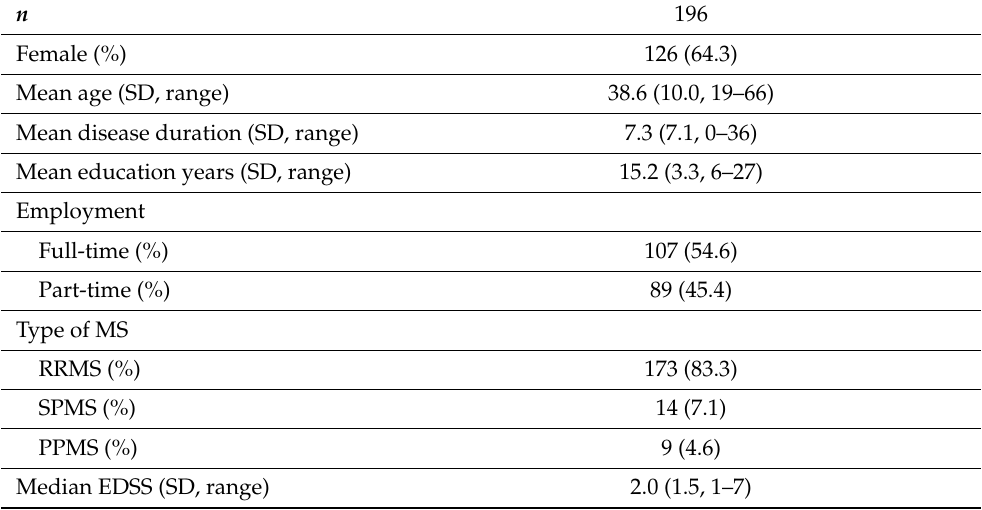
Table 1. Demographic and disease characteristics of the study population.